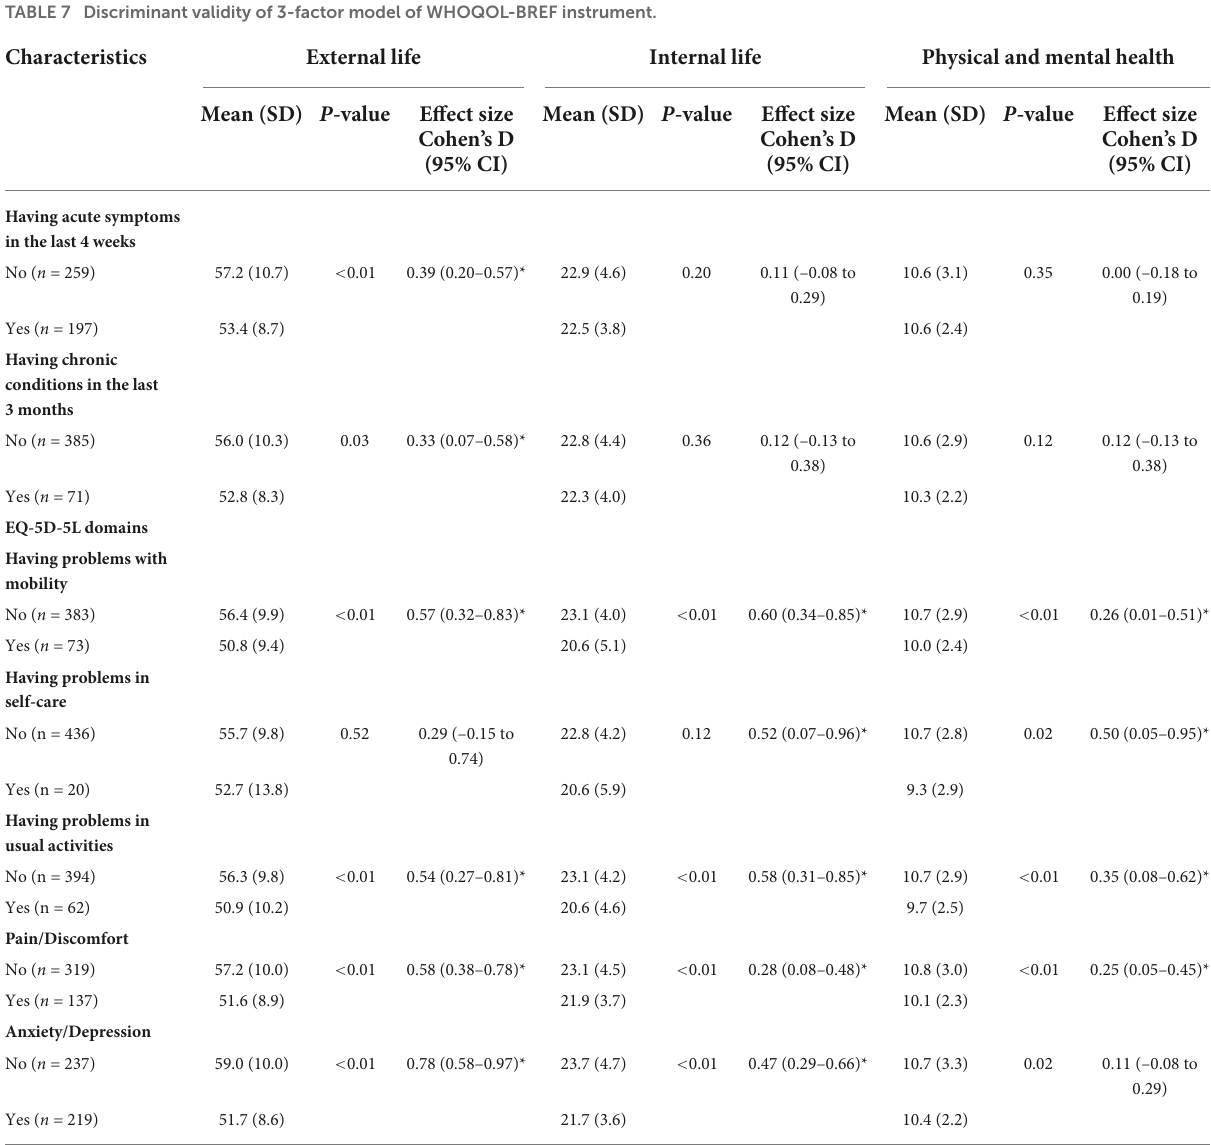
TABLE 7 Discriminant validity of 3-factor model of WHOQOL-BREF instrument.